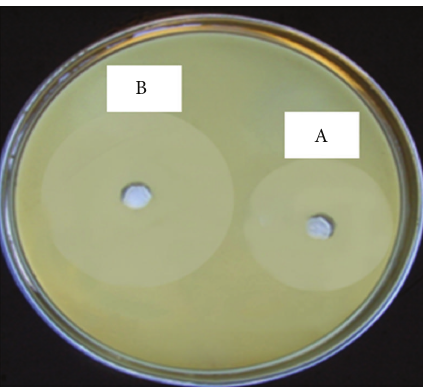
Figure 5: Antimicrobial activity of BACYAS 1 on E. amylovora upon using non-optimized conditions (A) and optimized conditions (B).